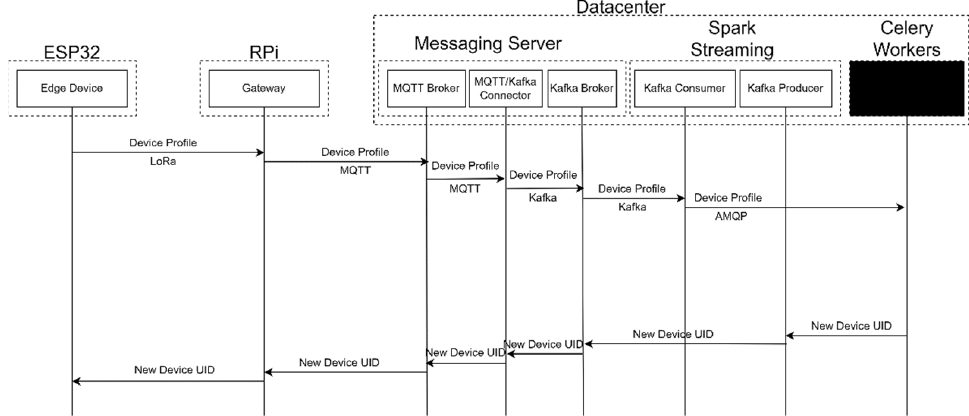
Figure 12. Sequence diagram for the third step of adding a new device.